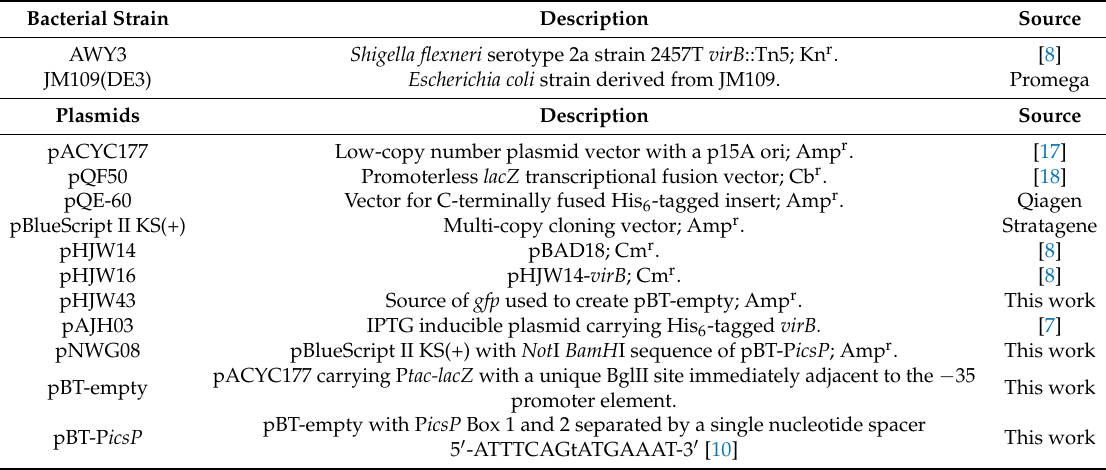
Table 1. Bacterial strains and plasmids used in this